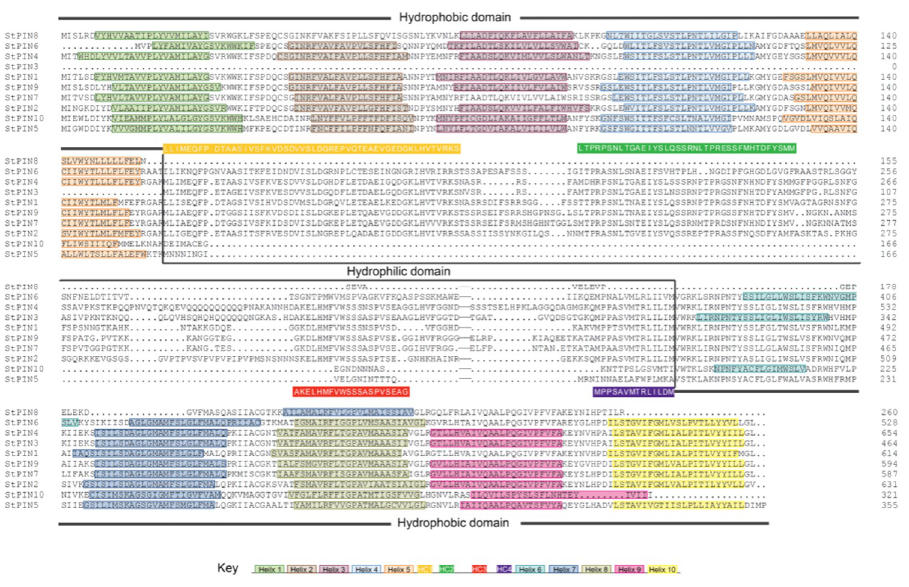
Figure 3. Trans-membrane and modular loop structure analysis of potato PIN proteins. Alignment results of StPIN proteins were conducted by DNAMAN software (https://www.lynnon.com/pc/ framepc.html). Prediction of trans-membrane helices within two highly conversed hydrophobic domains located at N- and C-termini were performed by the TMHHM Server v.2.0 (http://www.cbs.dtu.dk/services/TMHMM/) and shown by the rectangle filling with distinct colors. The motifs that constituted the highly conserved canonical regions HC1-HC4 within the common central hydrophilic region were shown as yellow, green, red and purple rectangles, respectively. The positions of predicted helices in potato StPIN proteins were listed in additional files: Table S2.